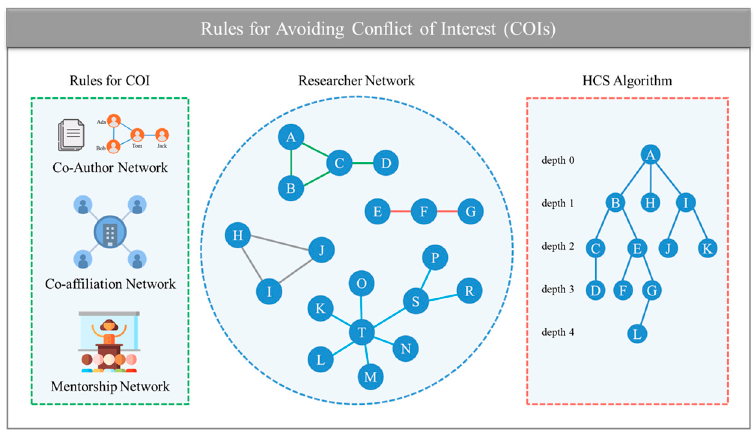
Figure 6. Rules for avoiding CoI.